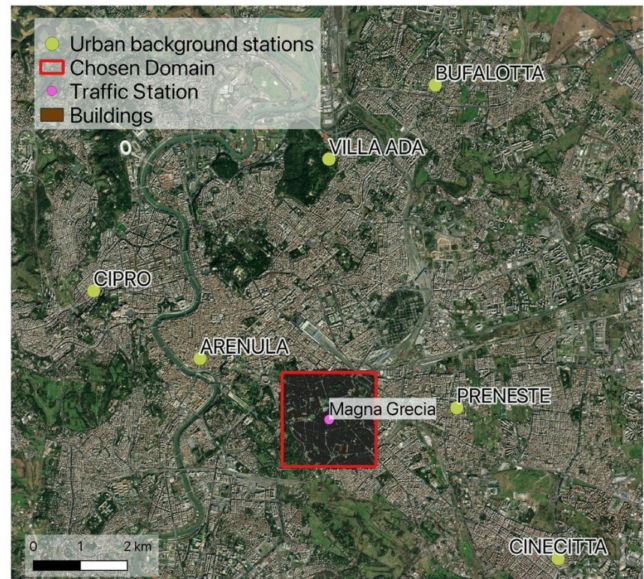
Figure 5. Maps reporting the location of urban background air quality stations. The yellow points were used for the calculation of the background NOx concentrations, while the pink point represents the urban traffic station of Magna Grecia inside the simulation domain (the area within the red